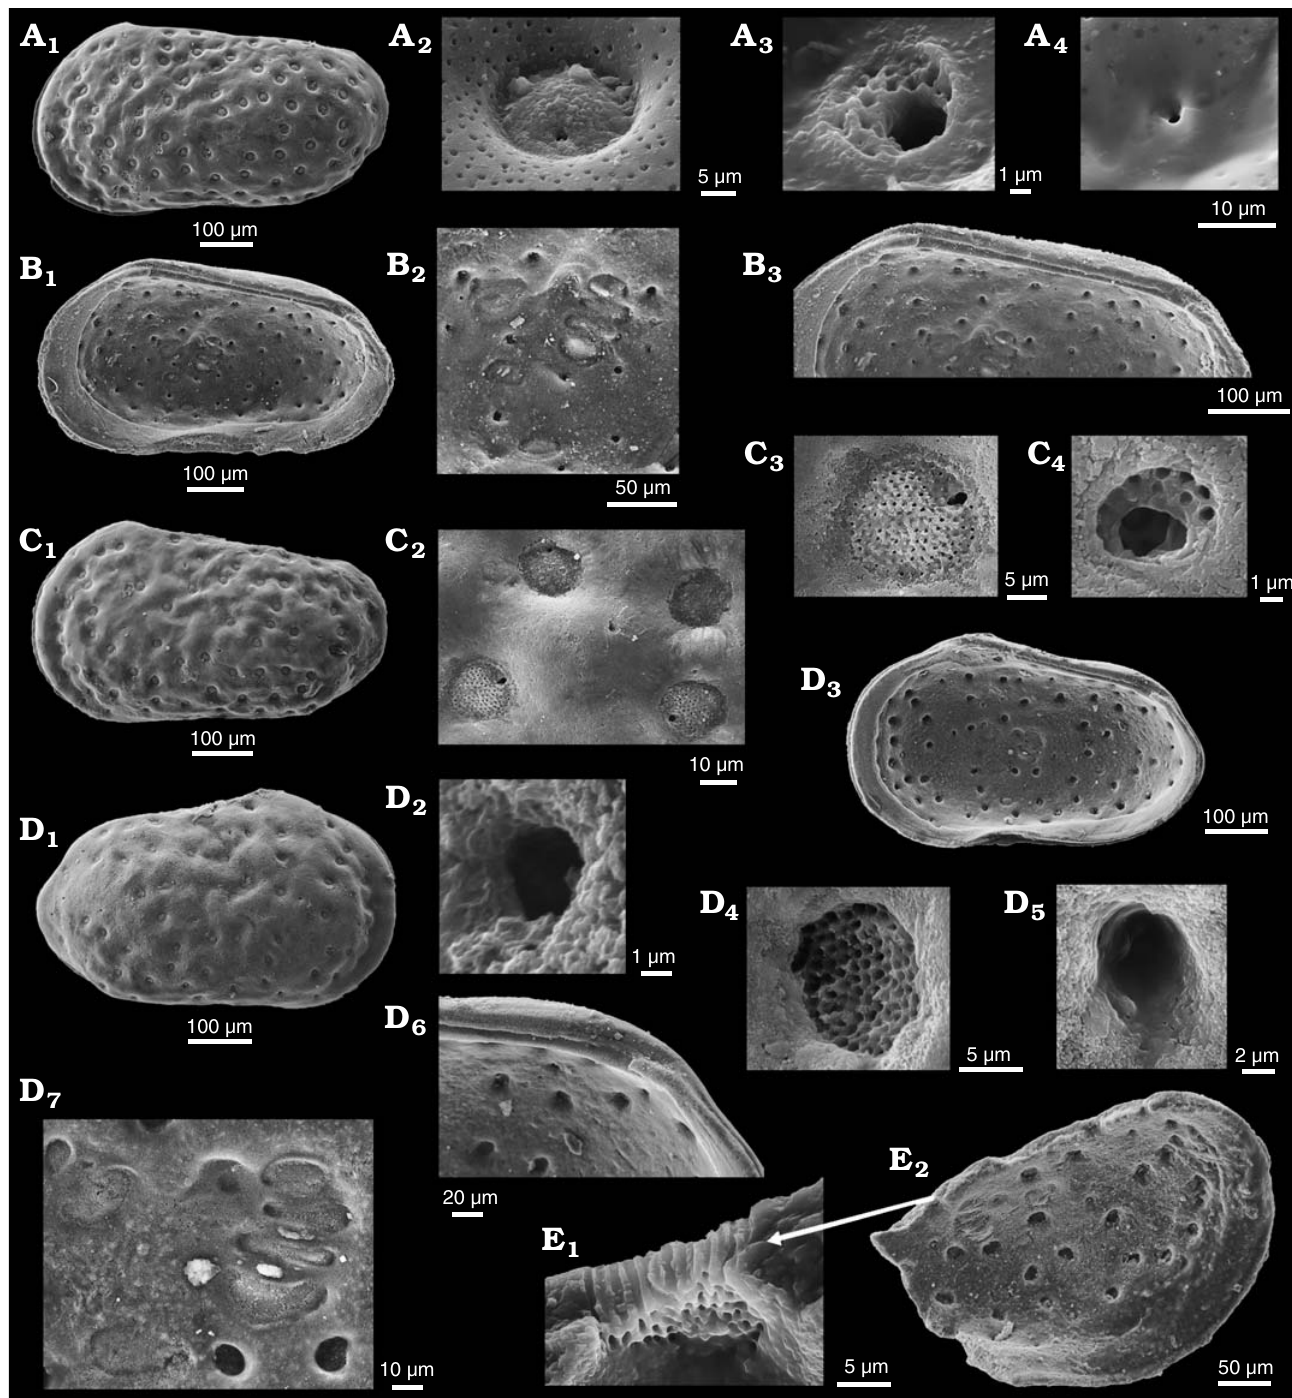
Fig. 14. Cytherid ostracod Minyocythere maculosa (Bate, 1963) from Everthorpe Quarry, South Cave, UK, Basement Beds, Bajocian (A, B) and Borehole Rodewald WA12, 395 m (C, D), 390 m (E), NW Germany, Witchellia laeviuscula Zone (Braun Jura γ ), Lower Bajocian. A . Topotype, SMF Xe 23744, male left valve in external view (A 1 ), macro sieve-type pore canals (StPC-M) (A 2 ), micro sieve-type normal pore canals (StPC-m) (A 3 ), and simple pore (A 4 ). B . Topotype, SMF Xe 23745, female right valve in internal view (B 1 ), muscle scars (B 2 ), hinge (B 3 ). C . SMF Xe 23746, male left valve in external view (C 1 ), StPC-M (C 2 , C 3 ), StPC-m (C 4 ). D . SMF Xe 23747, female right valve in external (D 1 ) and internal (D 3 ) views, simple pore (D 2 ), StPC-M (D 4 ), StPC-m (D 5 ), hinge, posterior part (D 6 ), muscle scars (D 7 ). E . SMF Xe 23748, interior of StPC-M (E 1 ), fragment of a left valve in internal view (E 2